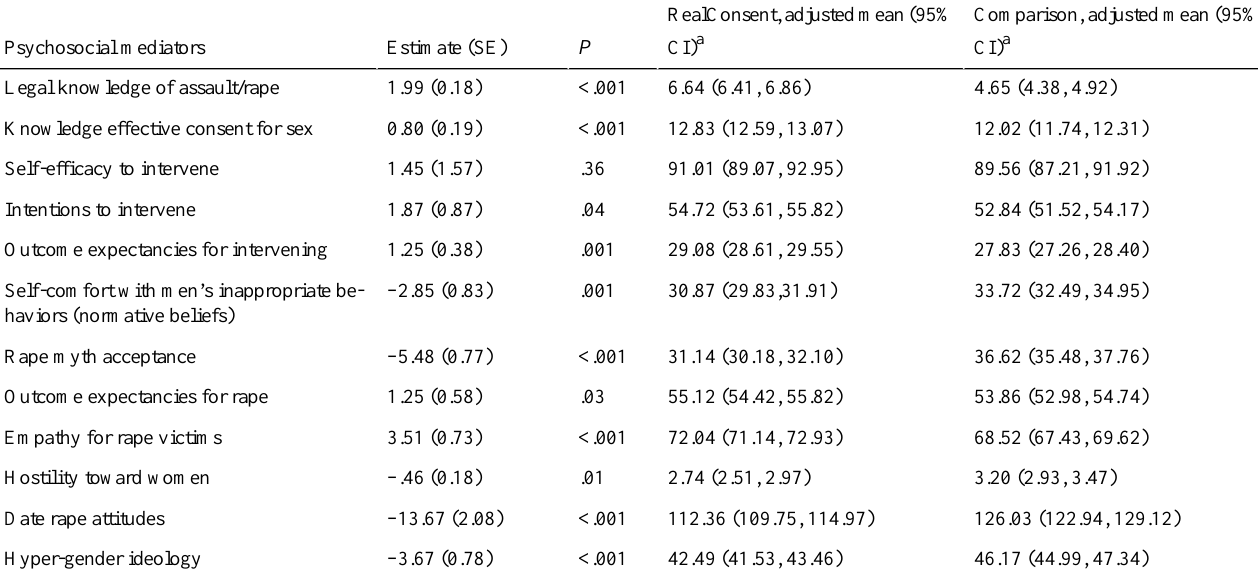
Table 3. Generalized estimating equation (GEE) regression models of intervention effects on psychosocial